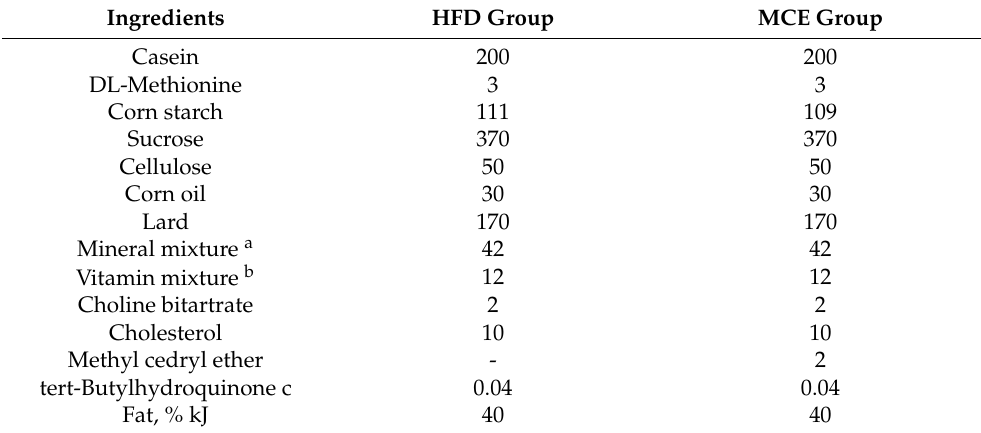
Table 1. Composition of the experimental diets (g/kg) fed to